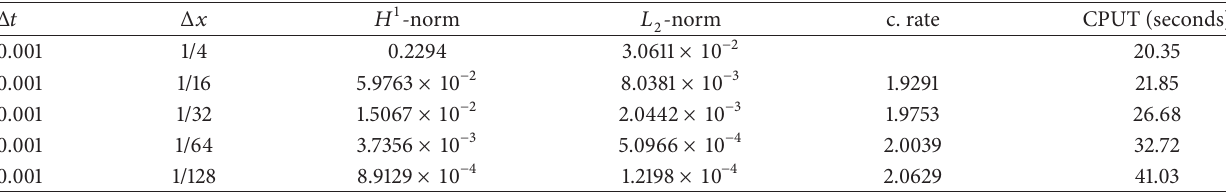
Table 2: Convergence rate in space for (46) with 𝛼 = 0.9 and 𝛽 = 0.5 .